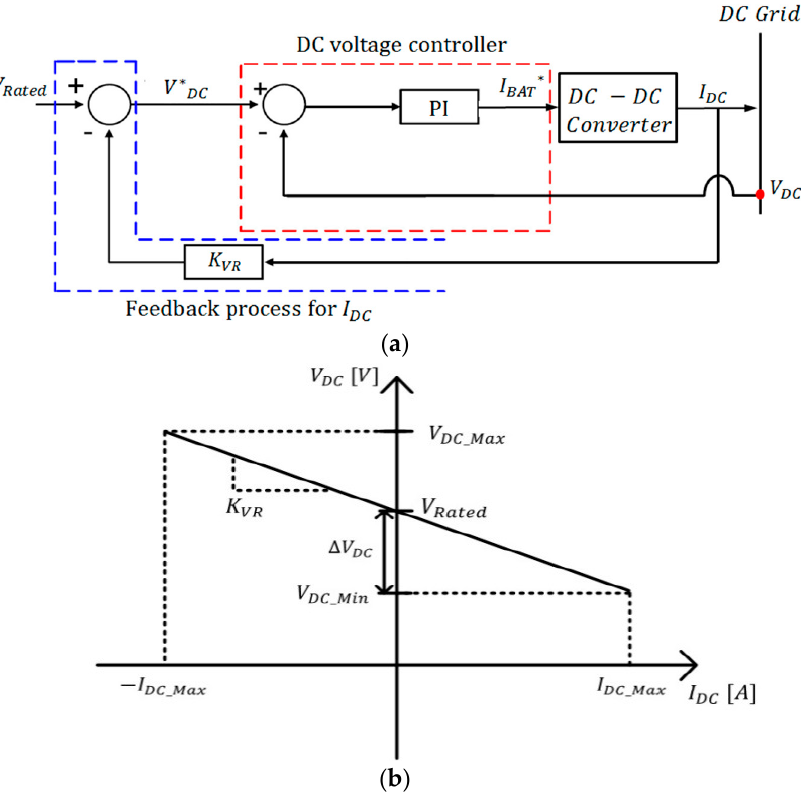
K relationship. Figure 2. Conventional droop control method: ( a ) reference grid voltage; and ( b ) K VR